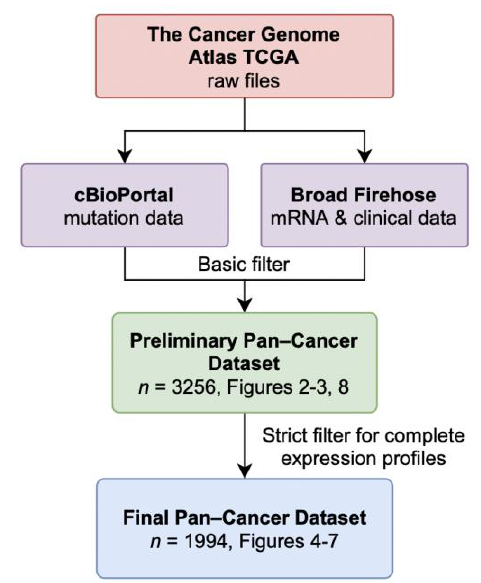
Figure 1. Data retrieval schematic and data composition. De-identified mutation files were down- loaded from cBioPortal.org, mRNA and clinical files were retrieved from the Broad Firehose using the R programming language. A basic filtering algorithm checked for conflicts and joined the files into the Preliminary Pan-Cancer Dataset with 3256 samples. A strict filtering algorithm removed samples with incomplete expression files required for the downstream analysis, resulting in the Final Pan-Cancer Dataset with 1994 samples. Table 1. Patient characteristics of the Preliminary Pan-Cancer Dataset and Final Pan-Cancer Dataset. Study Abbrv. Prelim.